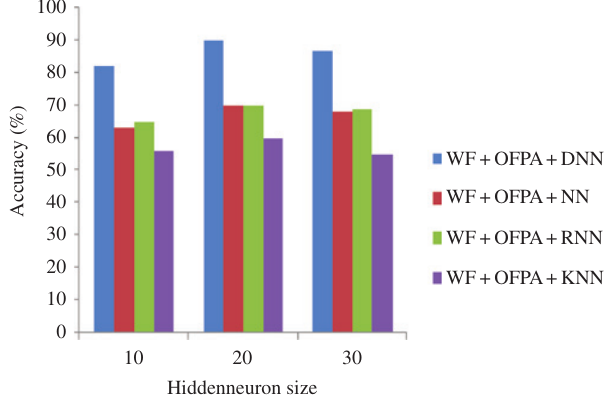
Figure 5: Performance of Proposed Approach Based on Accuracy.